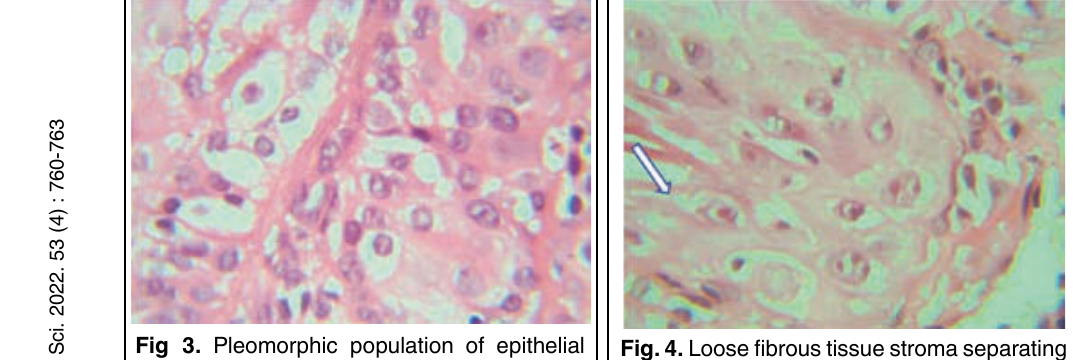
Fig. 4. Loose fibrous tissue stroma separating the large polygonal, weakly keratinised epithelial cells with prominent nucleoli and a few mitotic figures. (H&E staining,